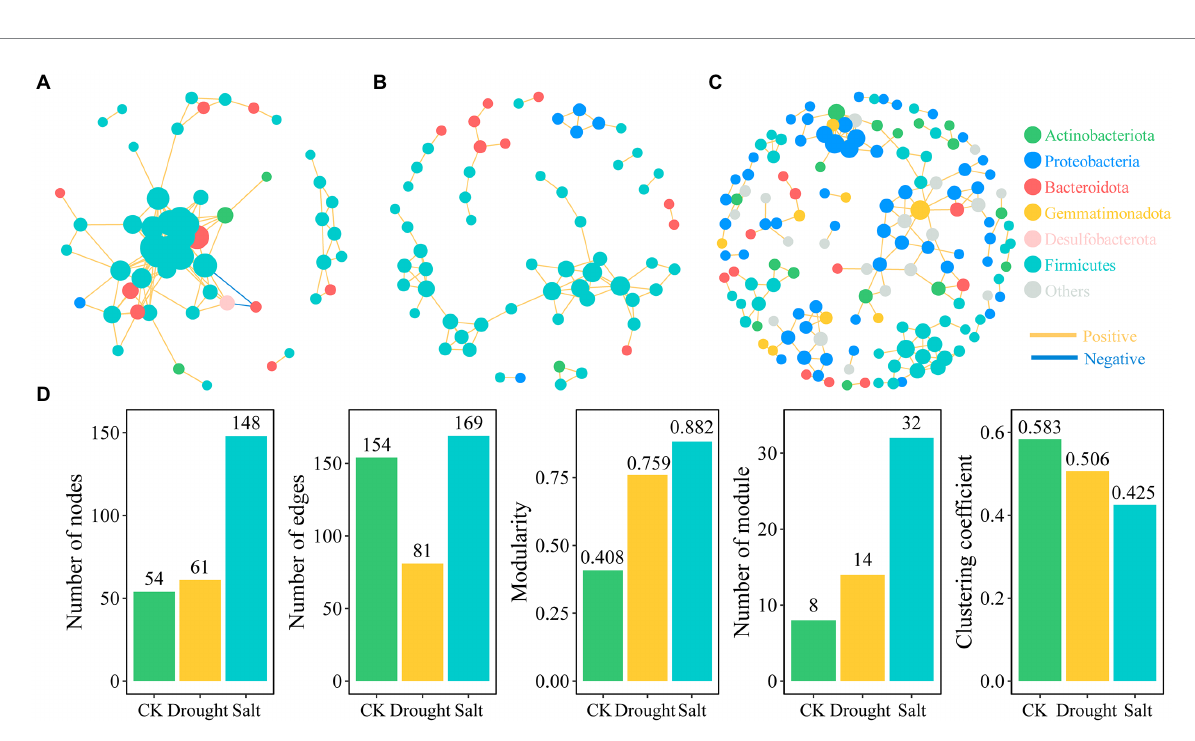
FIGURE 4 Bacterial networks based on correlation analysis of Nitraria tangutorum rhizosphere soil under different stress ( A : CK; B : Drought; and C : Salt) and the correlation between network properties and soil properties (D) . A connection stands for a strong (Spearman’s|r|> 0.9) and significant ( p < 0.01 after FDR correction). Colours of nodes indicate different major phyla while node size is proportional to node degree calculated from each ASV abundance correlation. The yellow lines indicate positive interactions whereas blue lines indicate negative interactions. (D) The network topological features of N.tangutorum under drought and salt stress.